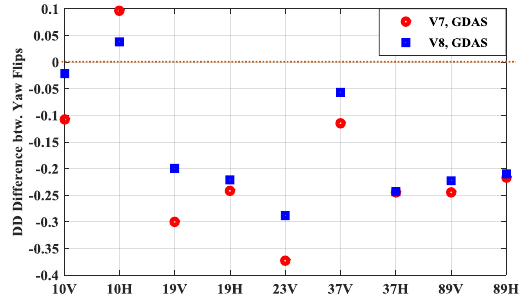
Figure 12. Mean double difference (DD) between Yaw 0° and 180° of each channel for both V7 ( red dots ) and V8 ( blue squares ).